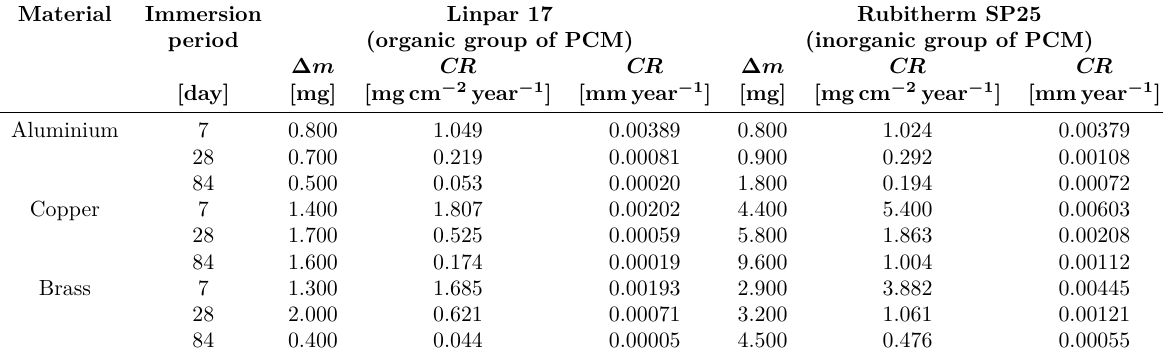
Table 4. The corrosion rates values of tested metals exposed to effects of selected PCMs from the organic and inorganic group for periods 7, 28 and 84